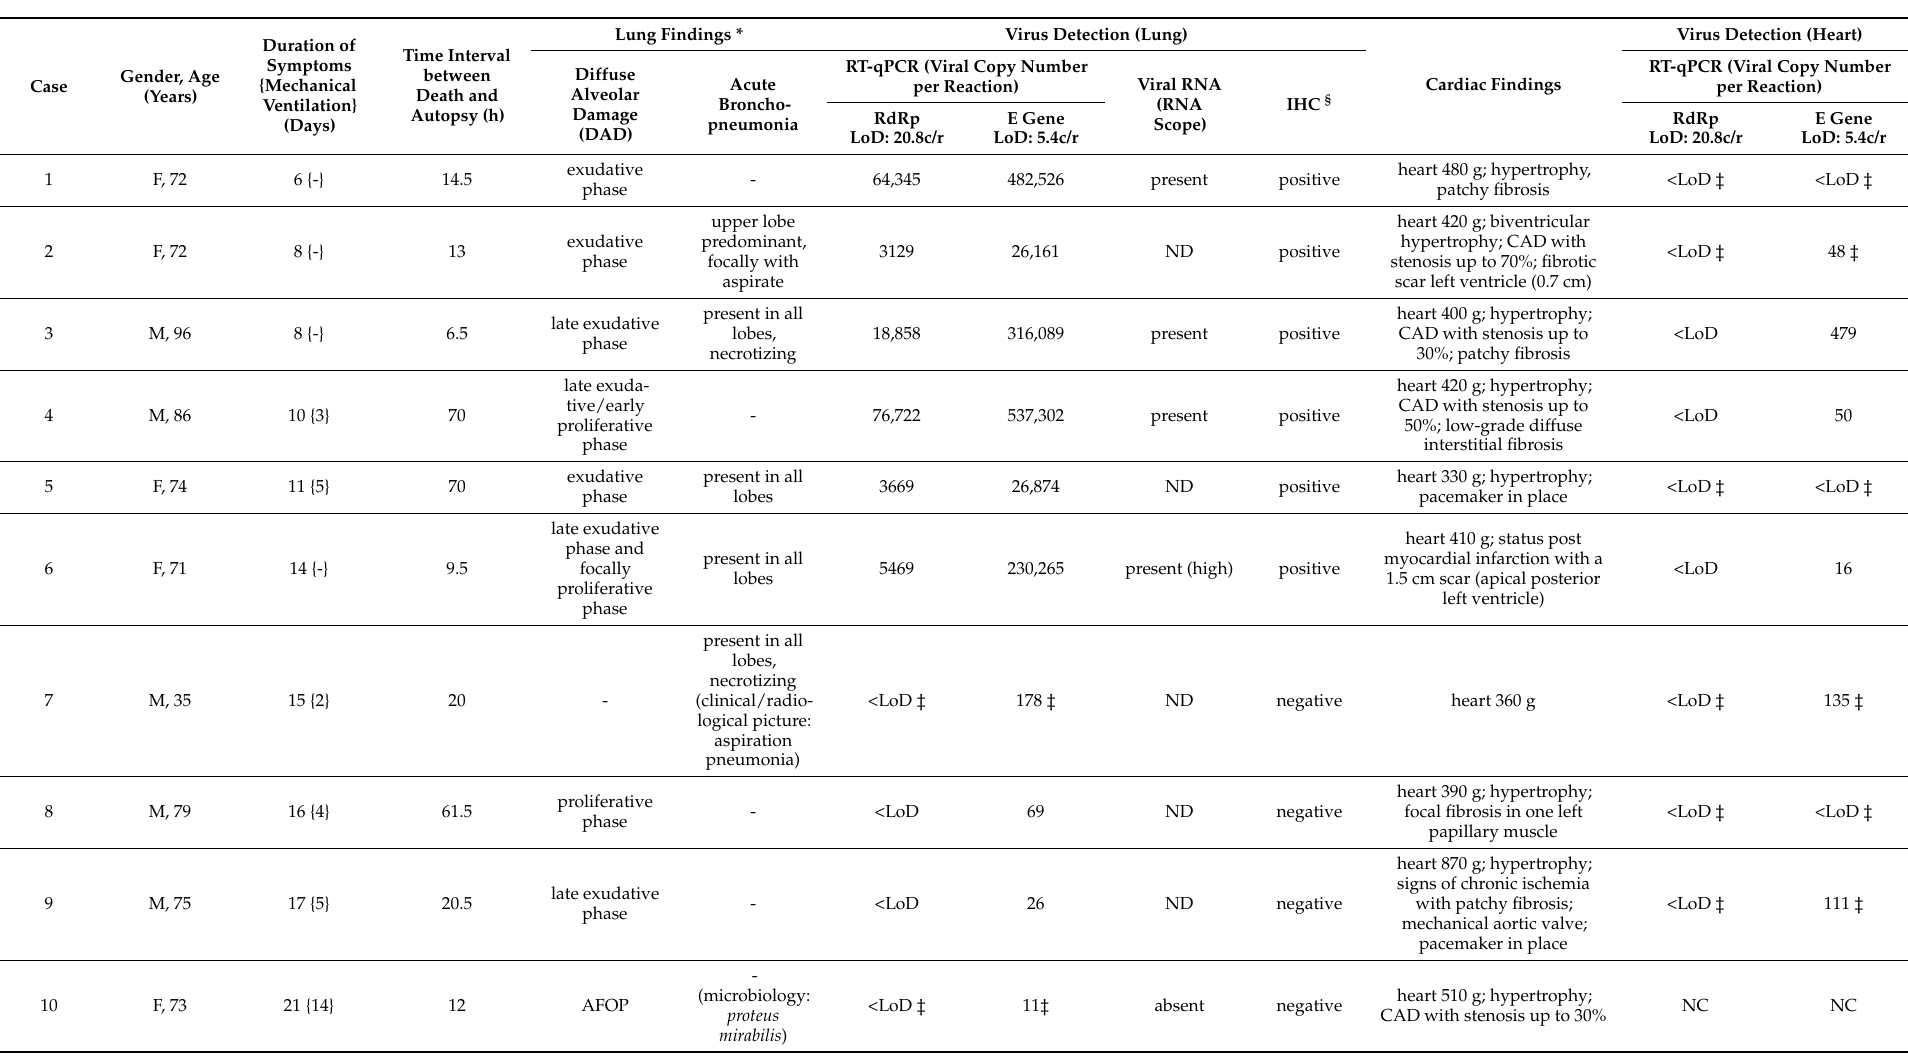
Table 3. Patient cohort including pulmonary, cardio-vascular findings and virus detection in lung and heart tissue obtained during postmortem examination. Patients are ranked according to duration of